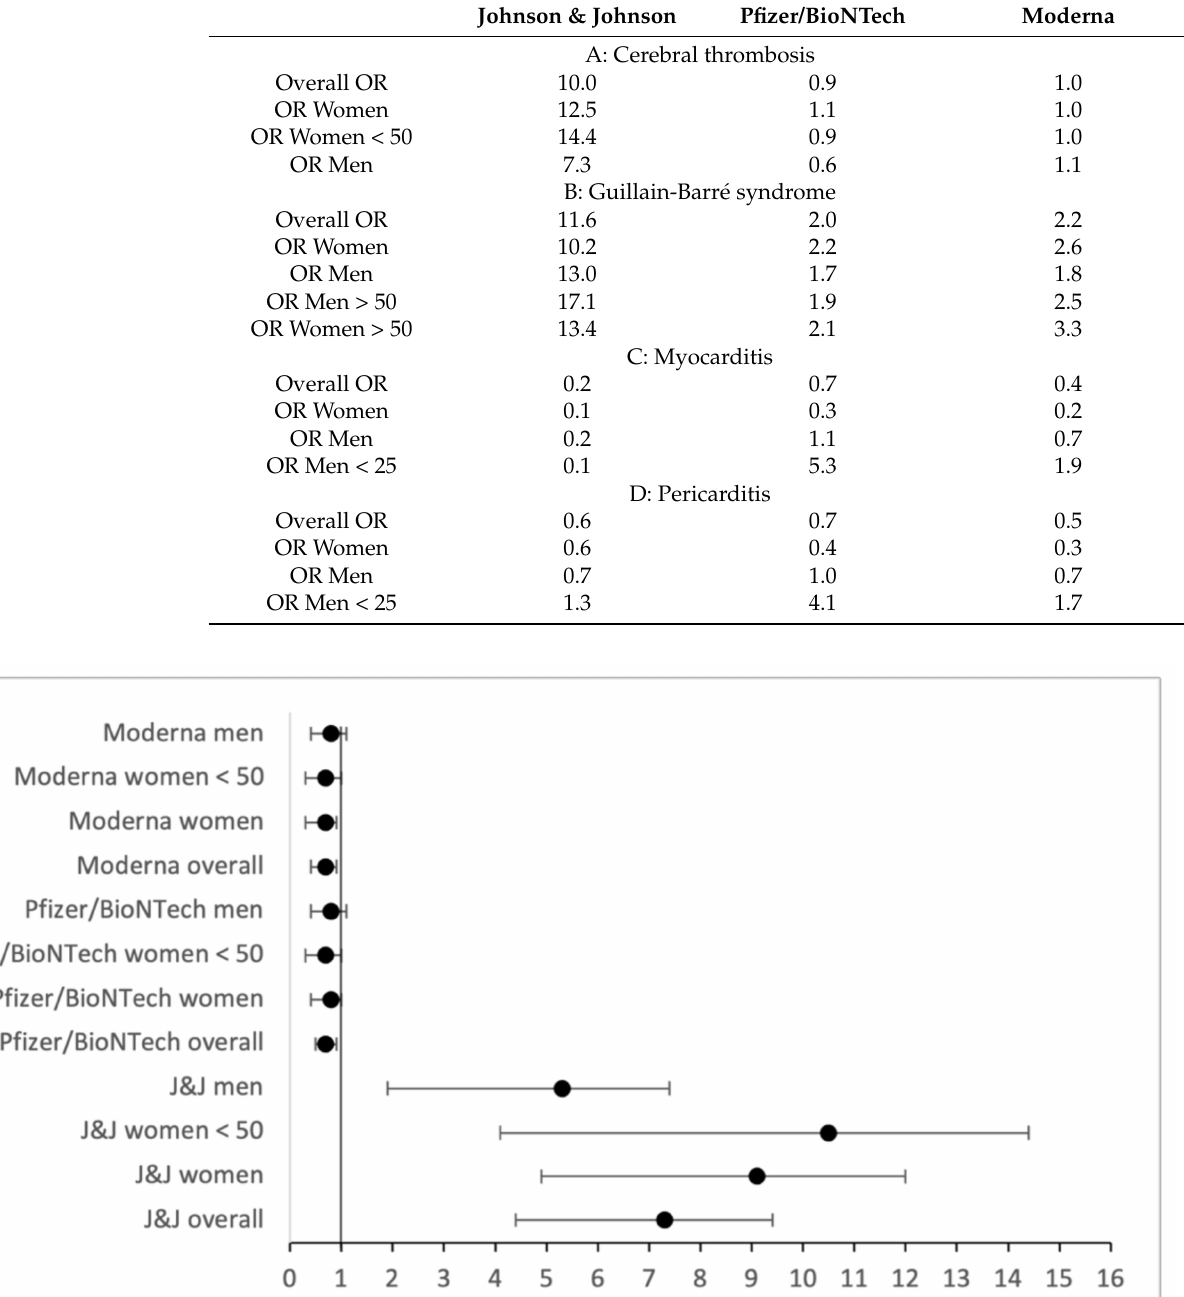
Table 2. Overview of odds ratios.